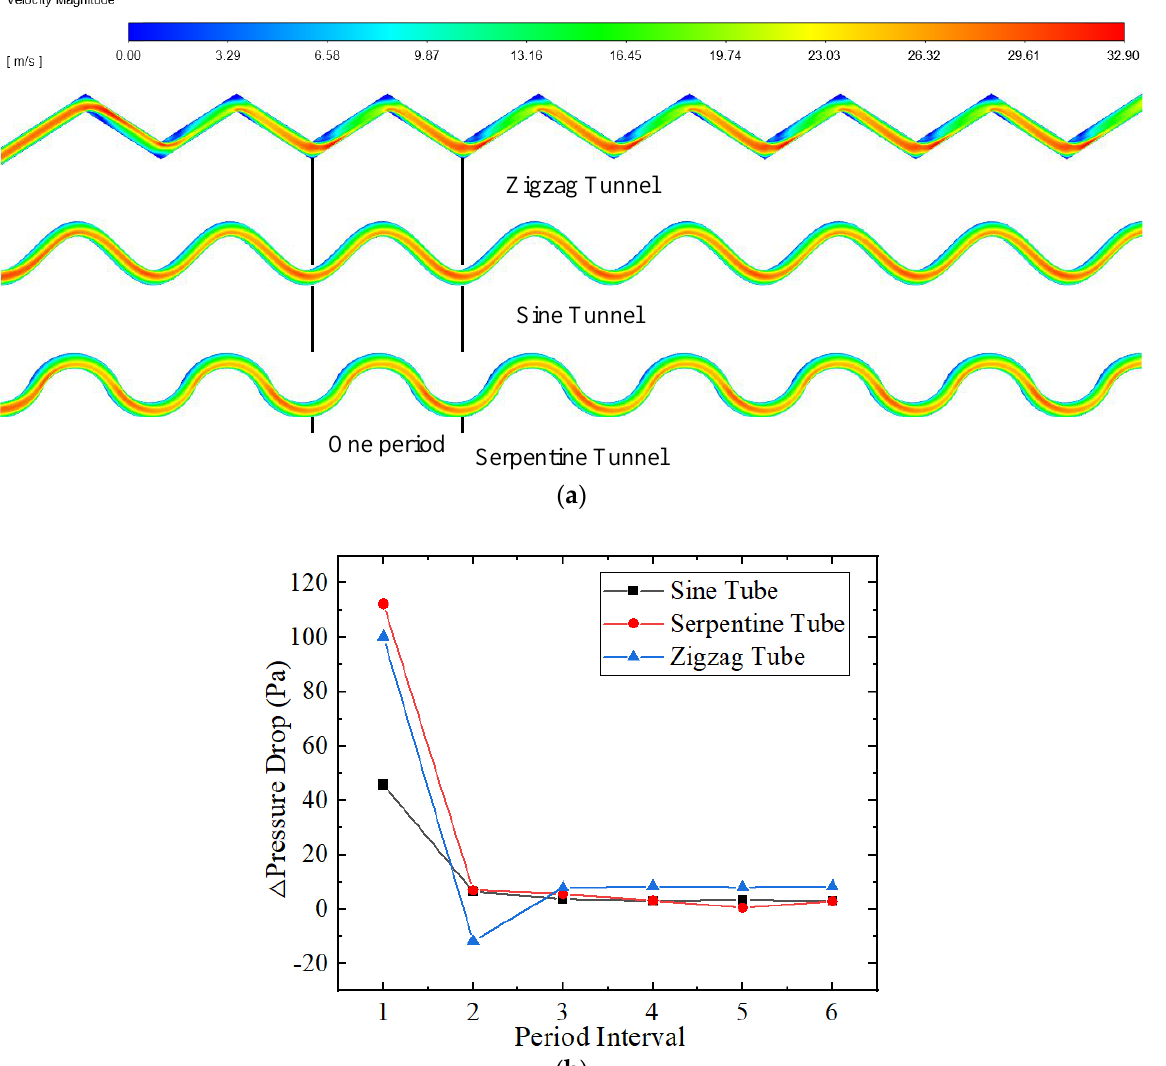
Figure 16. Periodic verification of flow pattern ( Re in = 2500, 29% Xe). ( a ) The cross-section velocity distribution in the X–Y plane. ( b ) The △ Pressure Drop of different periods.